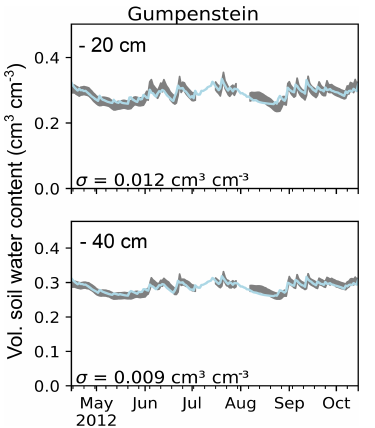
Figure 2. Parameter estimation at Gumpenstein: calibration period with soil water content measurements (gray) from two depth levels, including the calibrated measurement error σ , and prediction with median parameter estimates (blue).